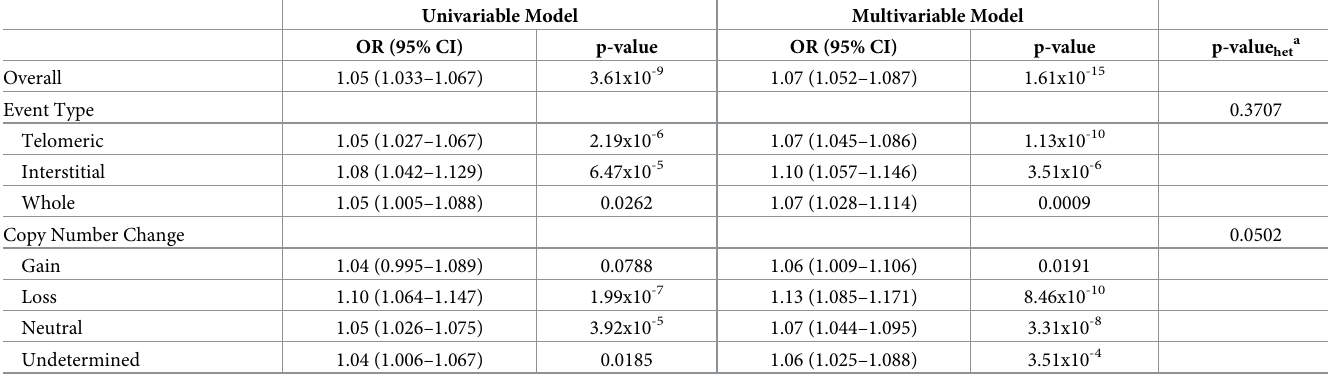
Table 3. Association between genetically-predicted telomere length and autosomal SCNAs by event type and copy number